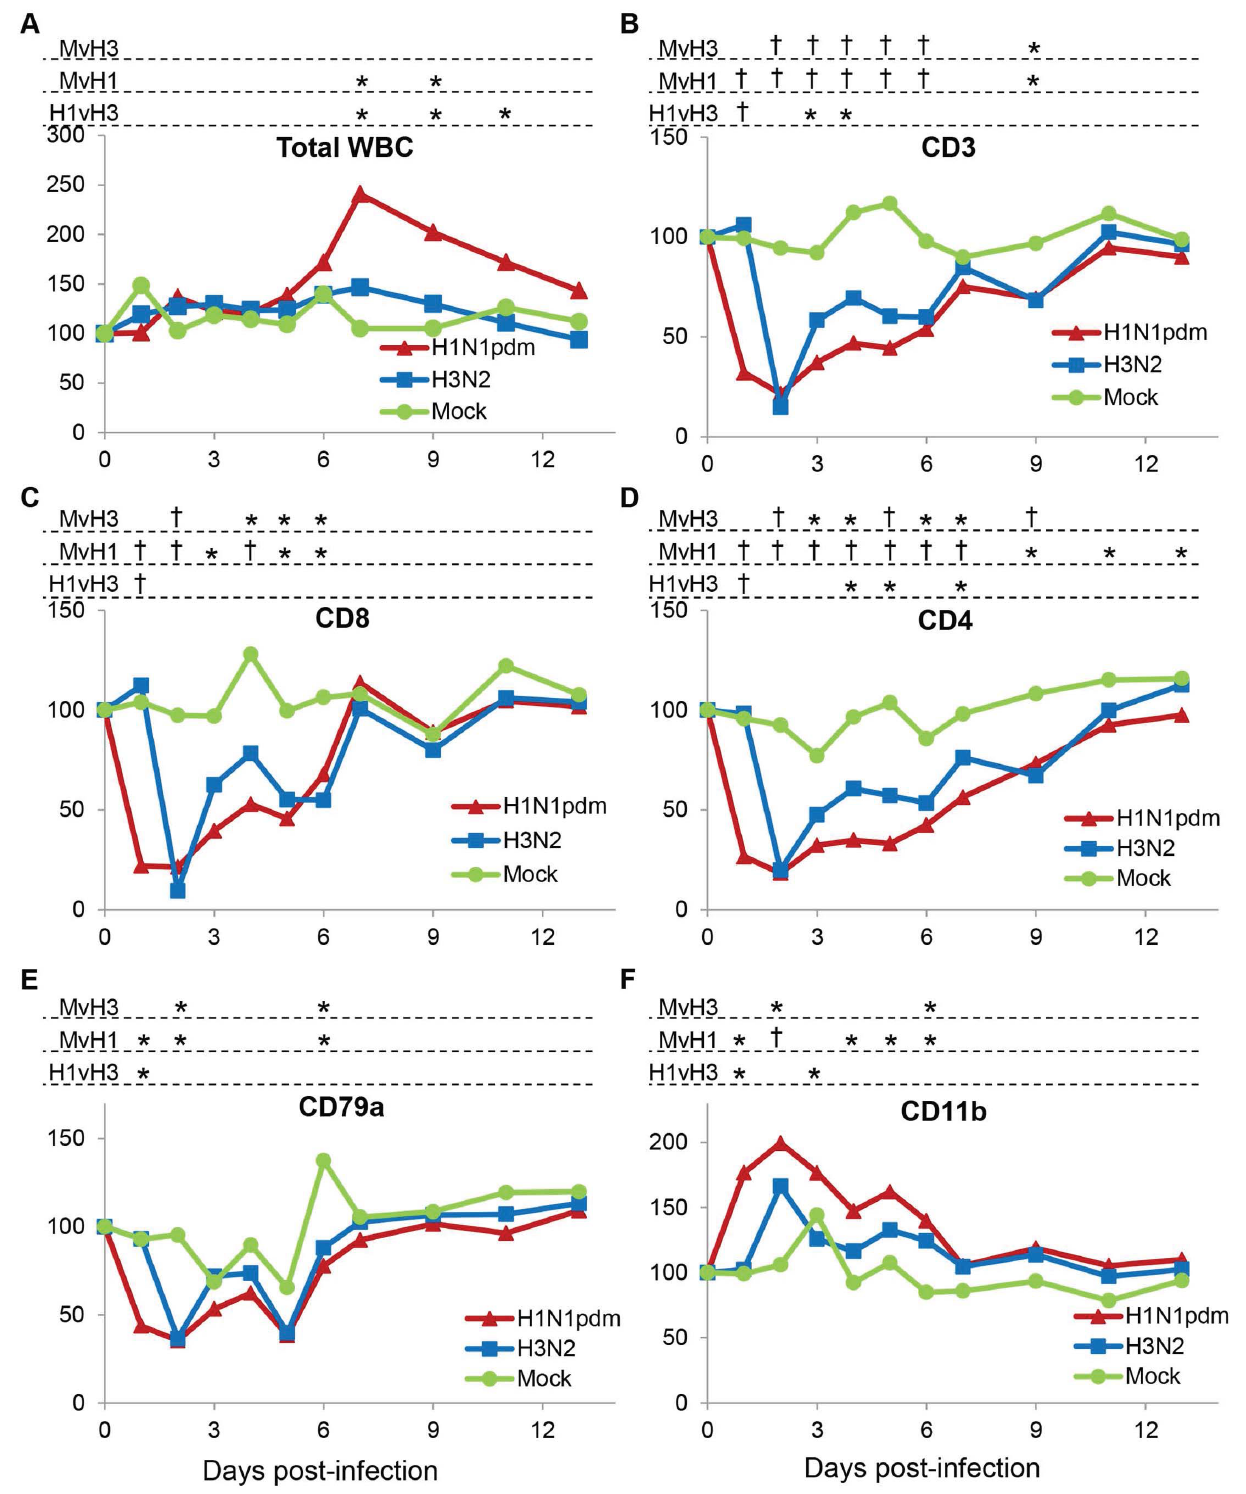
Figure 5. Peripheral blood leukocyte subsets following infection of naı¨ve animals with Perth/16 and NY/21. Ferrets were bled on days 0–7, 9, 11, and 13 relative to the day of viral challenge, and cells were stained and analyzed by flow cytometry as described in the text. ( A ) Total white blood cell counts were obtained using a Hemavet apparatus. Percentages of ( B ) CD3-positive cells (T cells), ( C ) CD8-positive cells (cytotoxic T lymphocytes), ( D ) TH cells (CD3 + and CD4 + ), ( E ) CD79a-positive cells (B cells), and ( F ) CD11b-positive cells excluding CD11b-high/FSC-high cells (granulocytes) were measured. For each animal the frequencies were normalized to the ferret’s values on day 0; the Y axis represents percent of values on day 0. ‘‘Mock’’, unvaccinated mock-infected animals; ‘‘H3N2’’, unvaccinated animals challenged with Perth/16; ‘‘H1N1pdm’’, unvaccinated animals challenged with NY/21. { indicates p , 0.0001; * indicates 0.0001 , p , 0.05. ‘‘MvH3’’, comparing mock-infected ferrets to ferrets infected with